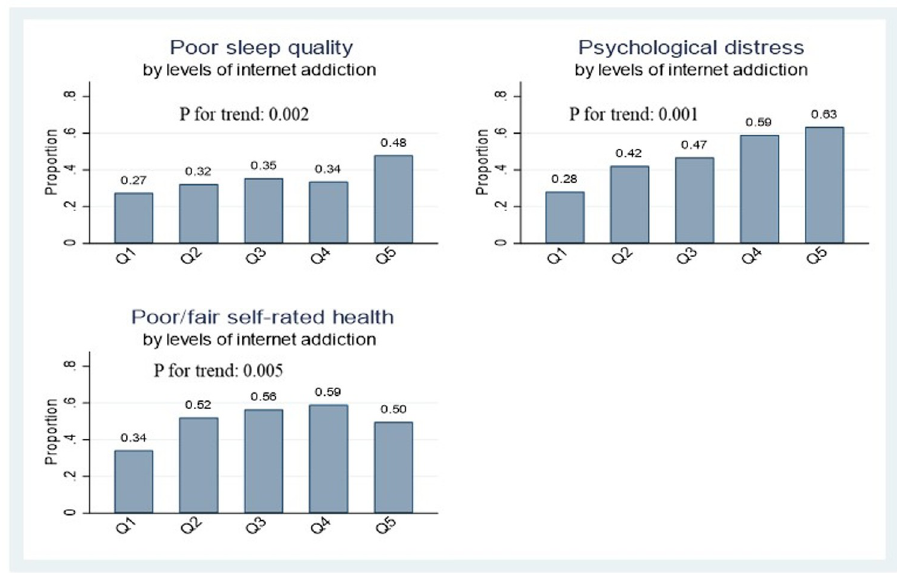
Fig 1. Distribution of poor sleep quality, psychological distress, and poor/fair self-rated health by levels of internet addiction (Q:quintile).